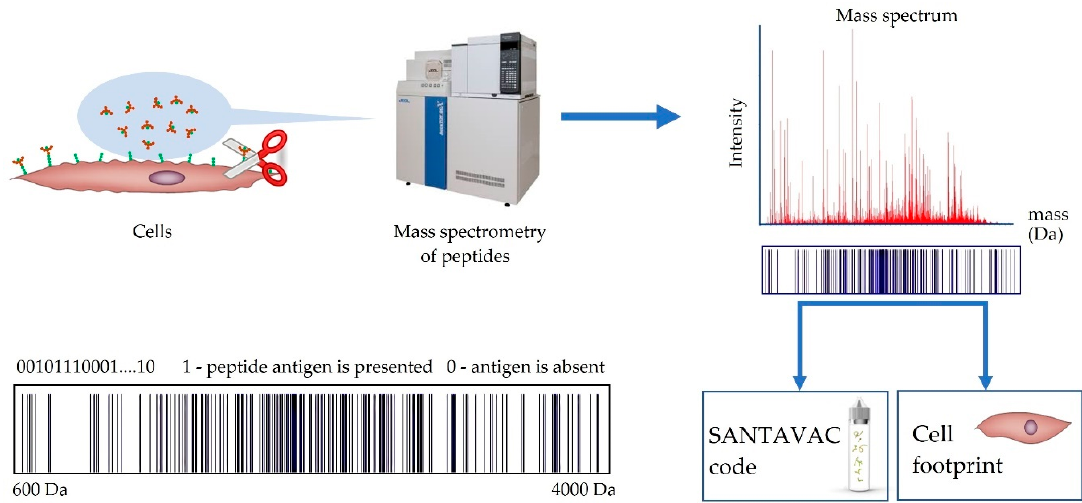
Figure 3. Workflow of cell proteomic footprinting. Adherent cell culture, after washing away traces of culture medium, is treated with a protease. Released fragments of the cell surface proteins are collected and analyzed by mass spectrometry. The set of obtained peptide molecular weights represents the SANTAVAC code and cell culture proteomic footprint. Comparison of these codes allows for authentication of the cells used to generate SANTAVAC, and also reveals any changes in its composition. This proteomic footprinting method was developed as a part of research and development (R&D) for SANTAVAC. Adapted from [50].